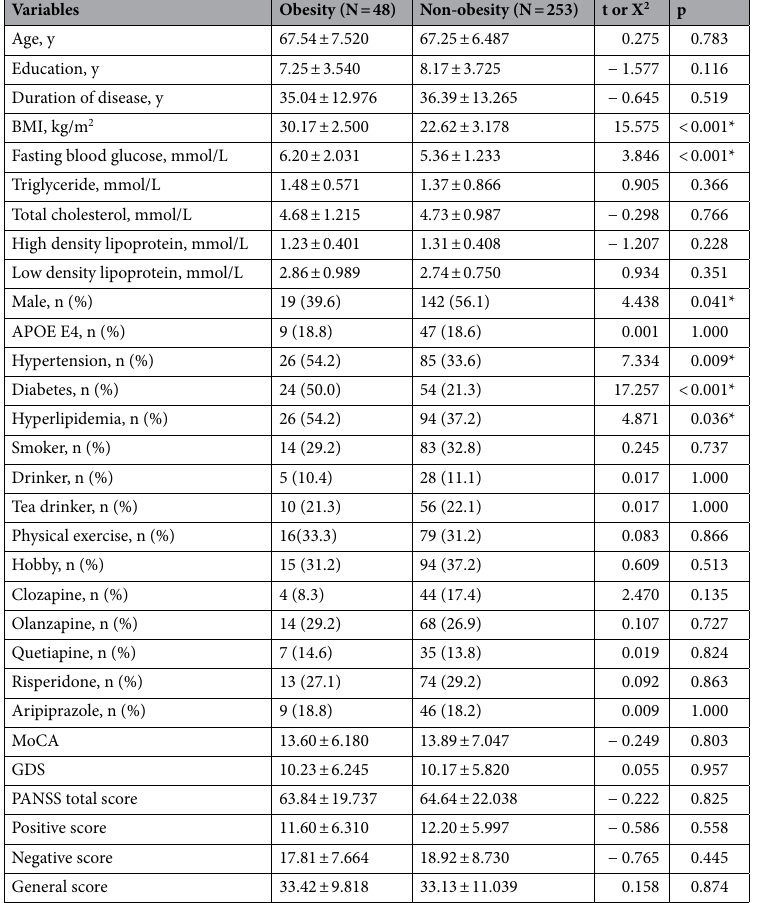
Table 1. General demographic data of the Chinese elderly with schizophrenia based on obesity. BMI body mass index, MoCA Montreal Cognitive Assessment, GDS Geriatric Depression Scale, PANSS Positive and Negative Syndrome Scale. *Means p < 0.05.